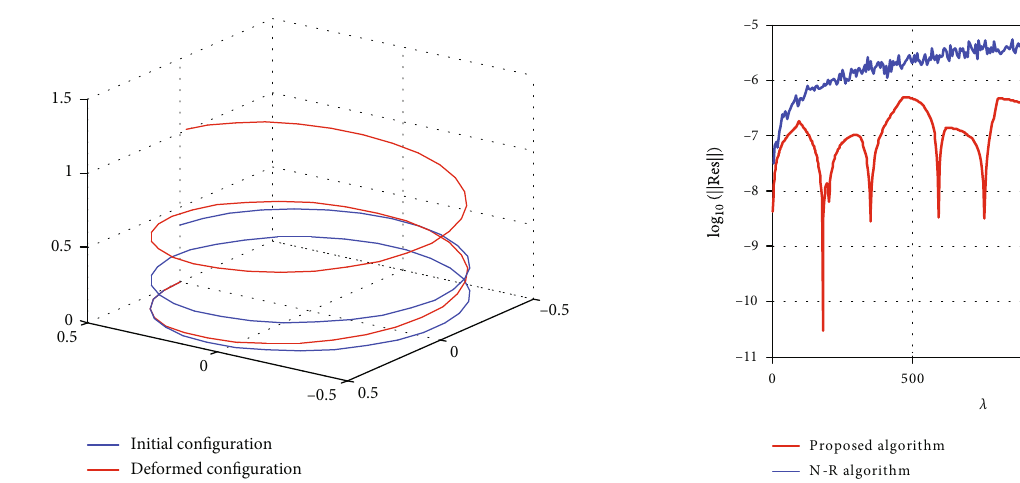
Figure 10: Decimal logarithm of the norm of the residue vector according to the loading parameter obtained by both